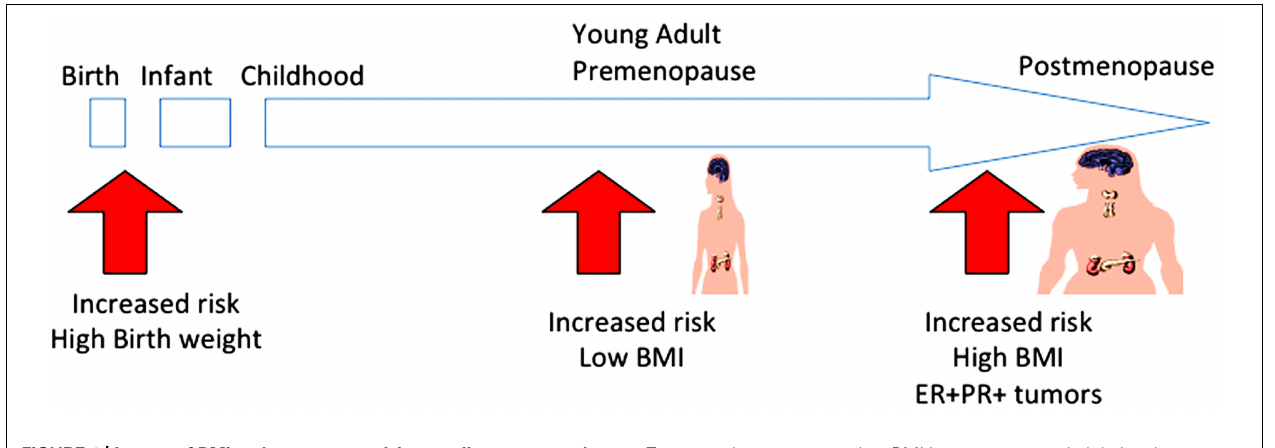
FIGURE 1 | Impact of BMI on breast cancer risk according to women’s life stage. Although body weight control is an effective strategy for preventing breast cancer, women’s life stages should be